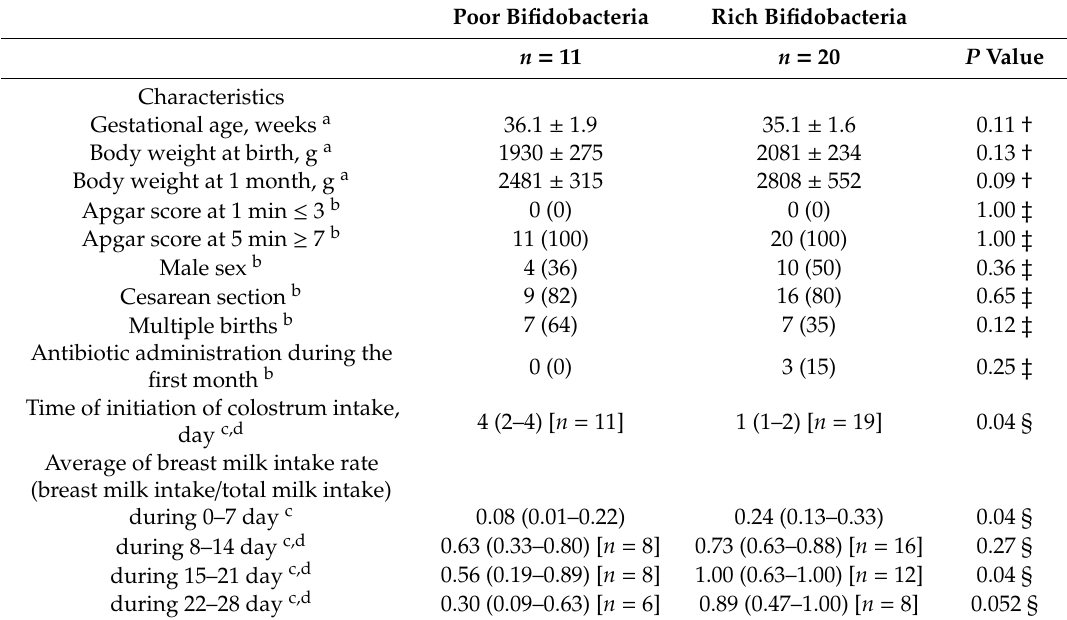
Table 1. Comparison of characteristics and feeding histories of subjects between the subpopulation in the N